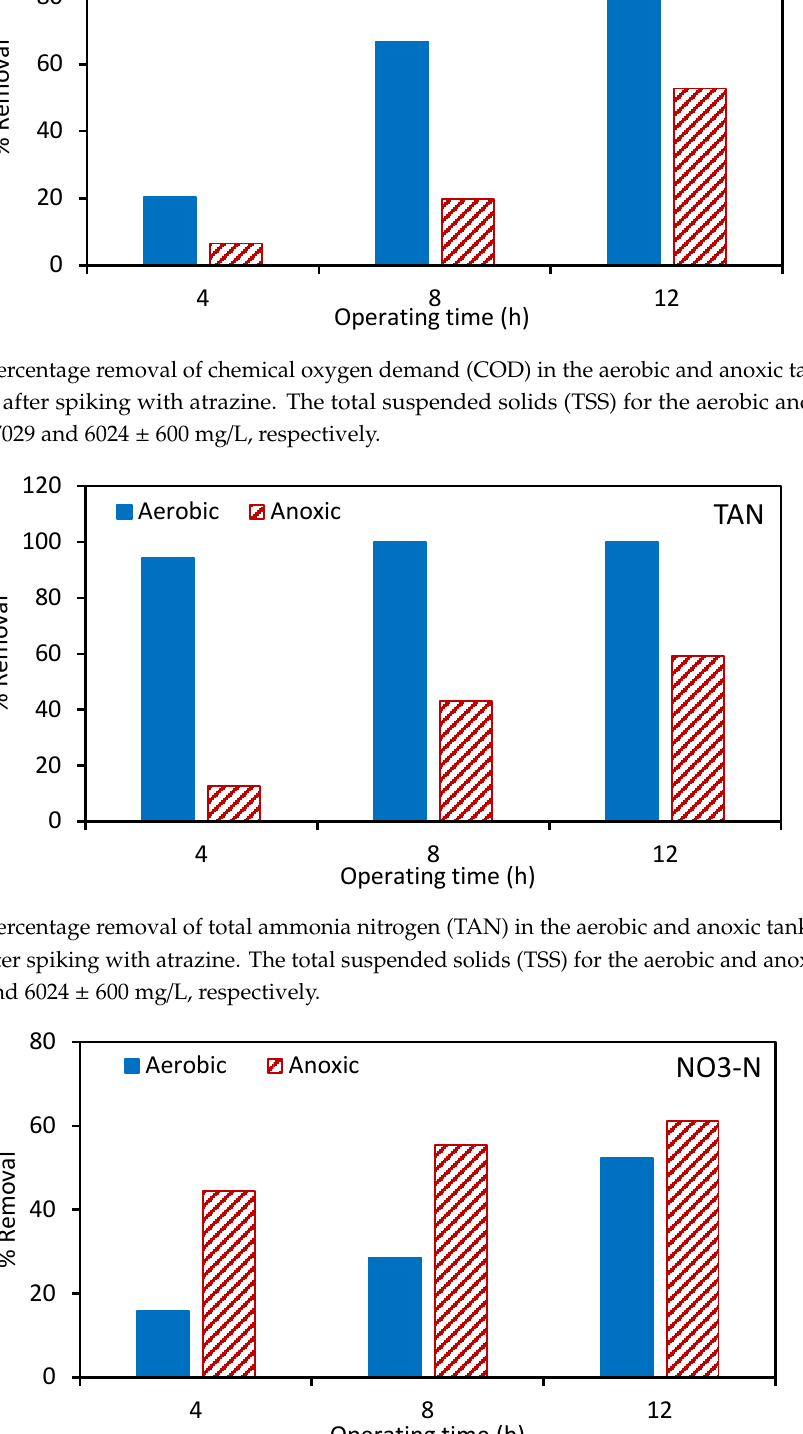
Figure 4. Percentage removal of nitrate nitrogen (NO 3 -N) in the aerobic and anoxic tanks at 4, 8, and 12 h after spiking with atrazine. The total suspended solids (TSS) for the aerobic and anoxic tanks was 7029 and 6024 ± 600 mg / L,